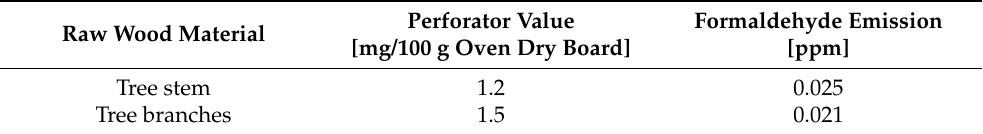
Table 5. Hygienic properties of 3-layer particleboards from tree stems and branches of